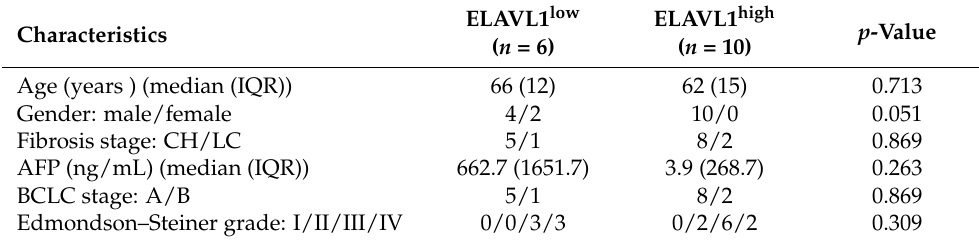
Table 2. Clinical features of ELAVL1 low and ELAVL1 high HBV-related HCC